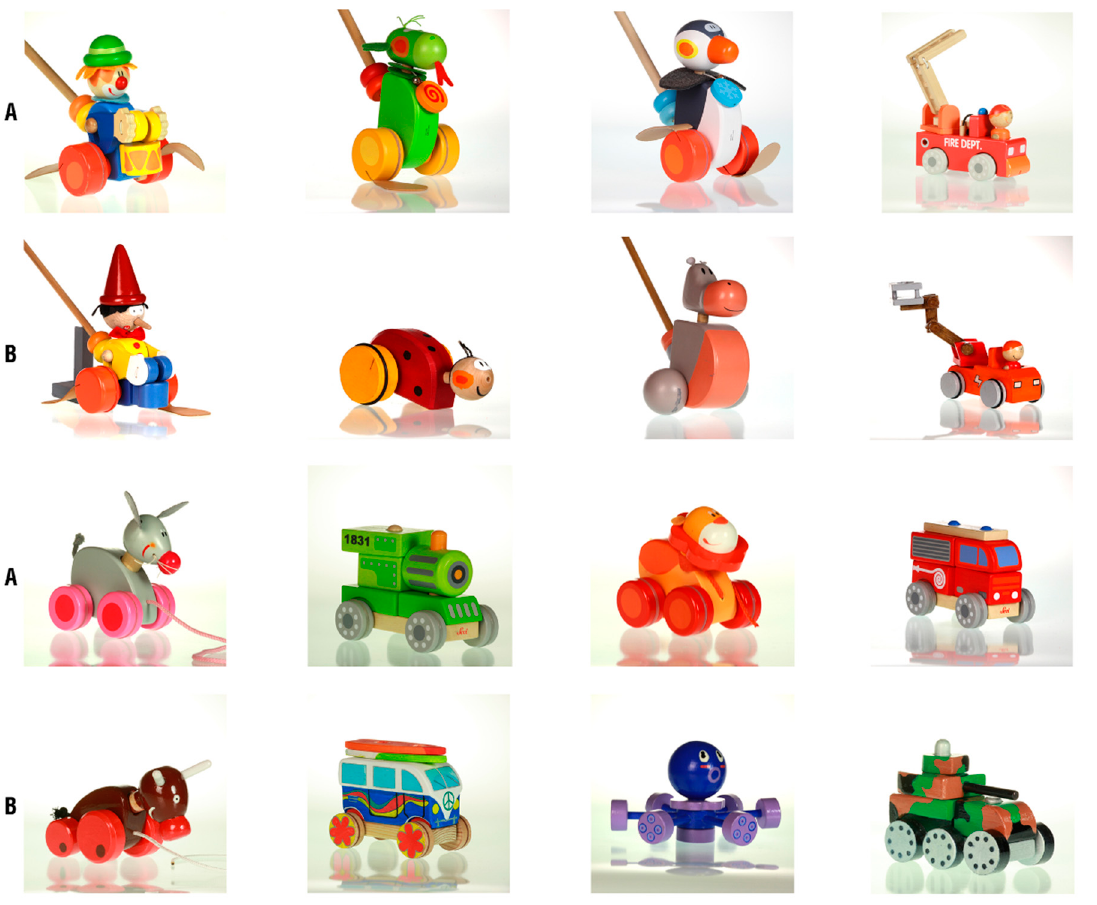
Figure 7. Original Sevi’s toys ( A ) and their metamorphosis; ( B ) wooden models by the students of the